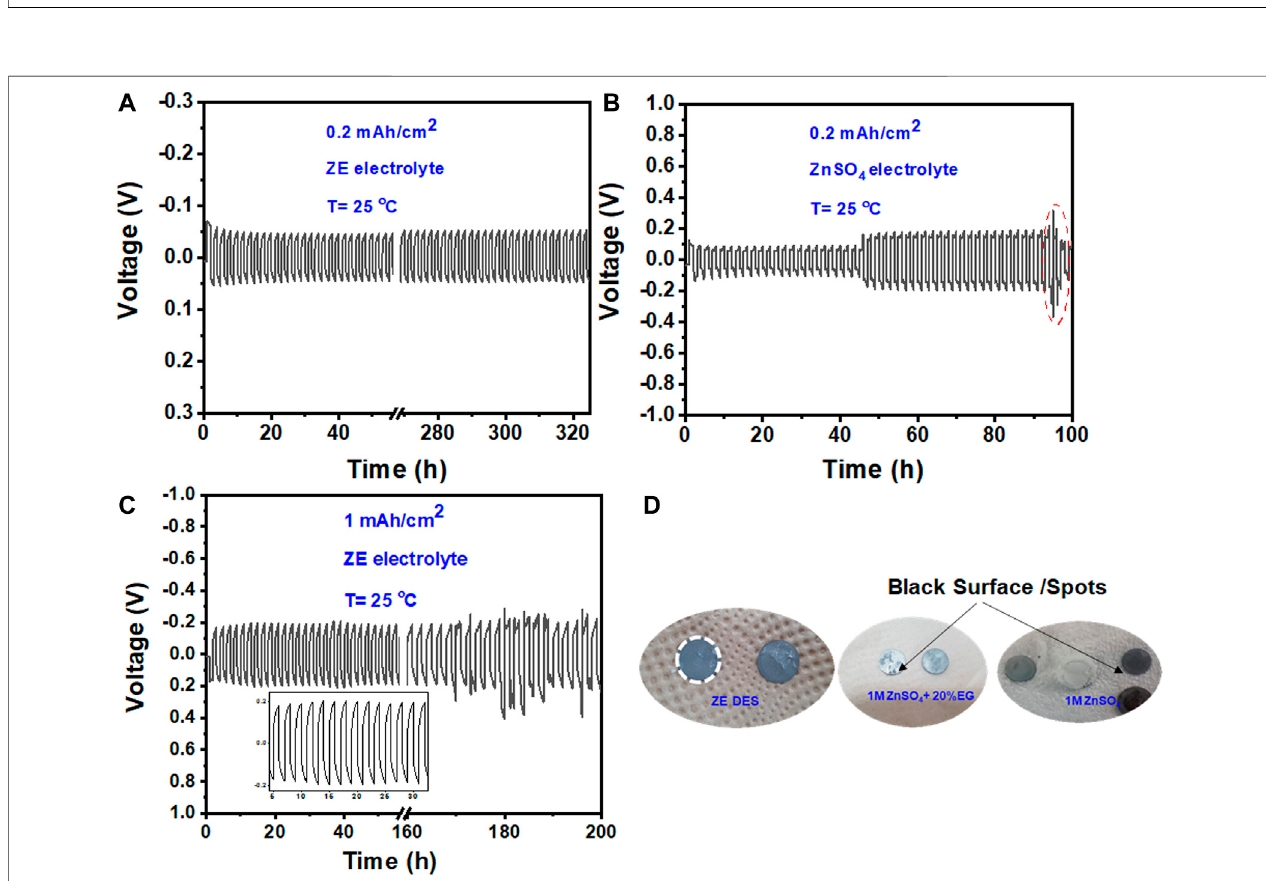
FIGURE 7 | Long-term stripping/plating performance of the Zn metal anode at 0.2 mAh cm − 2 in (A) ZE electrolyte and (B) aqueous 1 M ZnSO 4 , and (C) at the 1 mAh cm − 2 for ZE electrolyte. (D) Digital photographs of the Zn foil acquired after 50 cycles at 0.2 mAh cm − 2 .